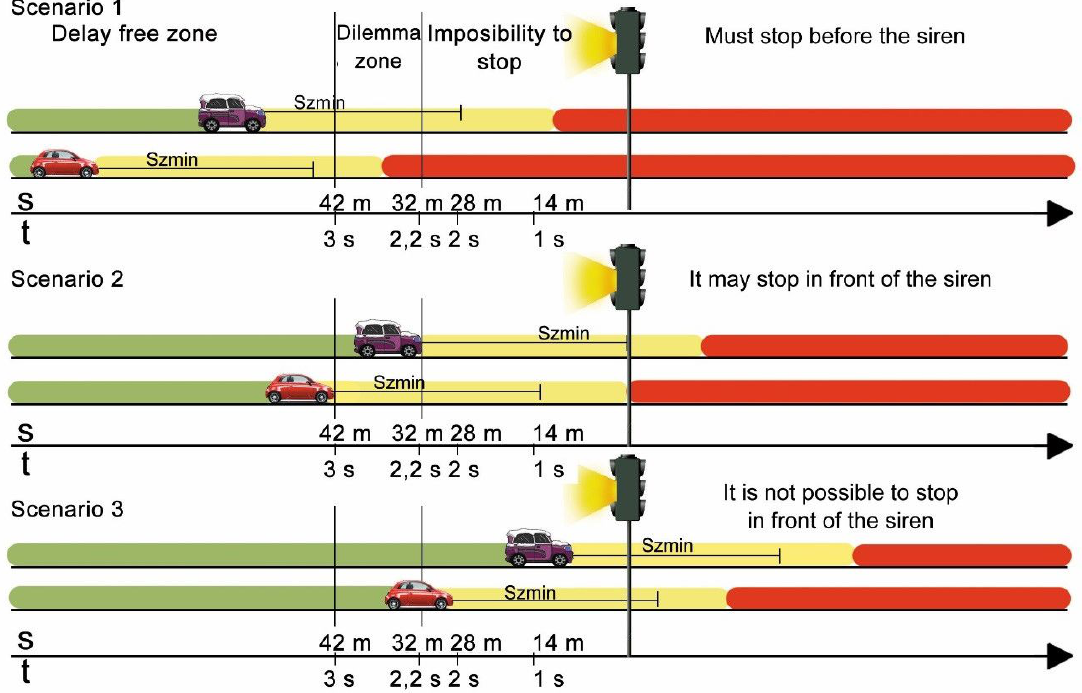
Figure 3: Graphic representation of sending a yellow signal for various positions of the car relative to the traflc light and possible subse- quent